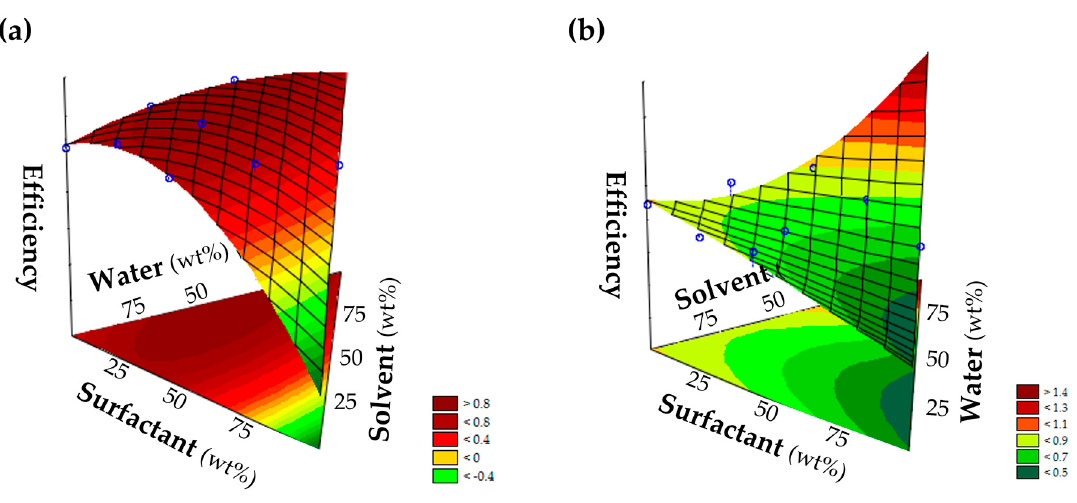
Figure 9. Response surface of cleaning efficiency for ( a ) ceramic and ( b ) stainless steel as a function of the composition of the ternary mixture in weight percentage (BDG (solvent), [N 1118 ][C 8 O 2 ] (surfactant), and water.